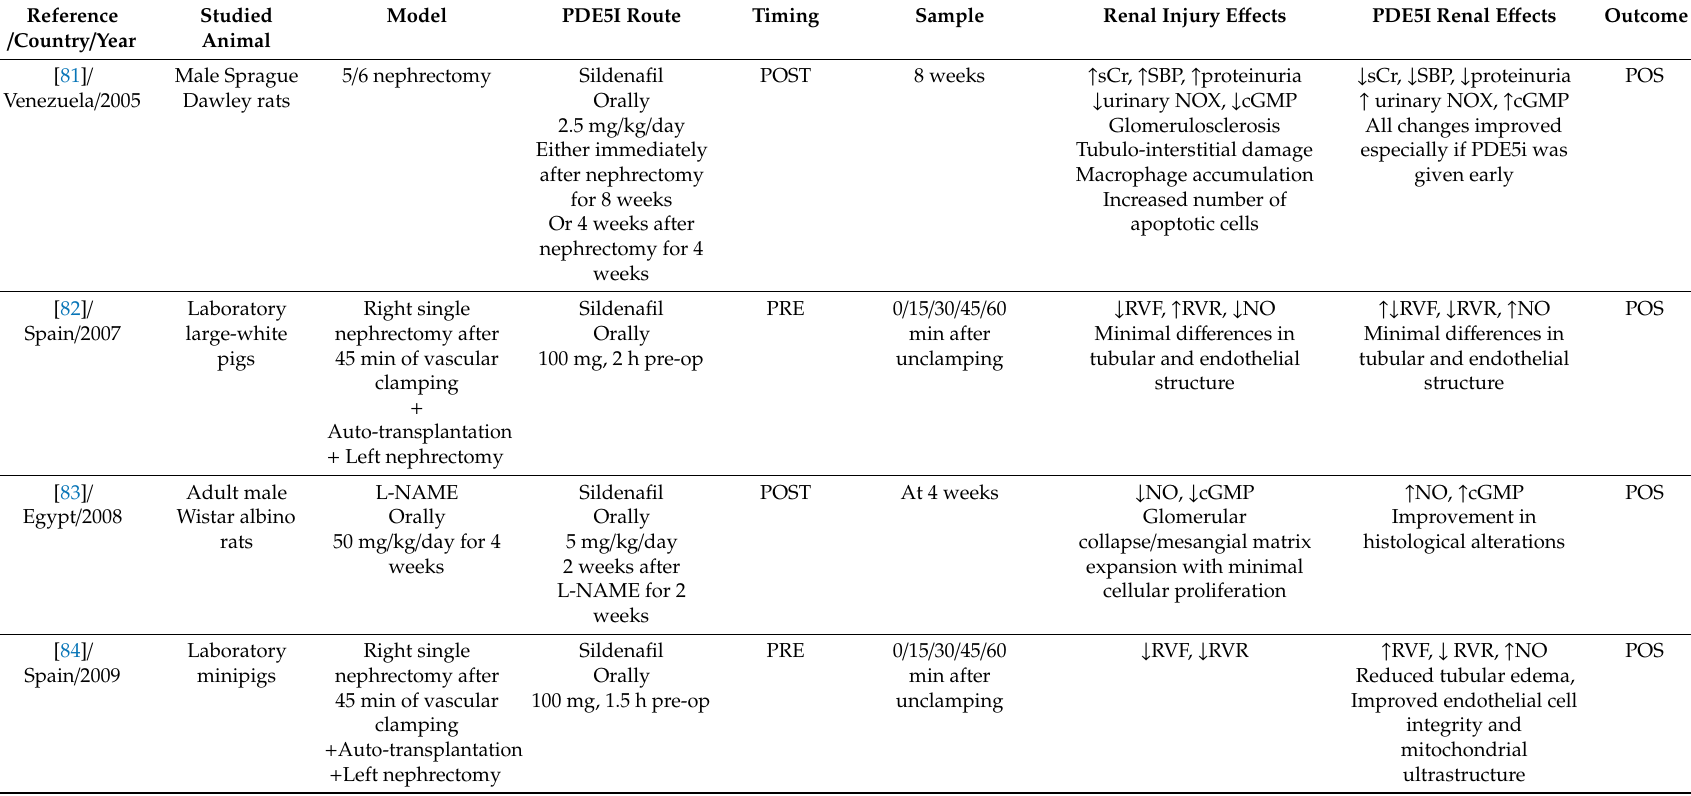
Table A1. Animal studies evaluating the potential reno-protective e ff ects of